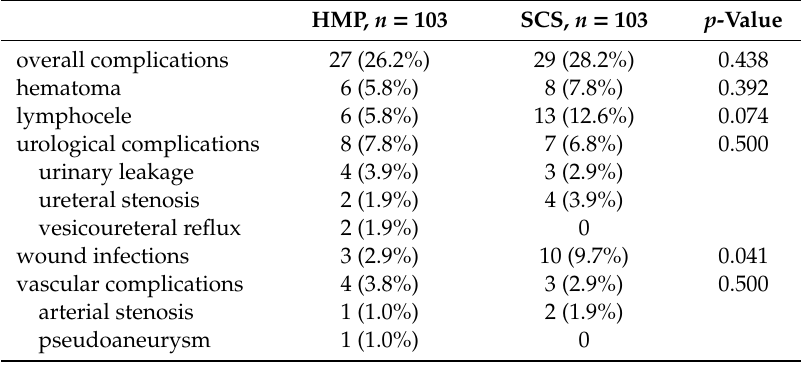
Table 4. Postoperative complications of the propensity-score matched